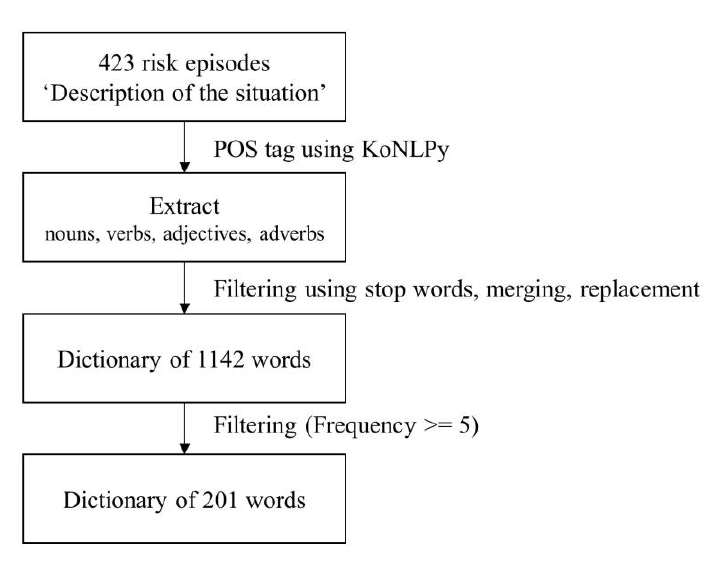
Figure 3. Preprocessing flow for the “description of the situation” item.